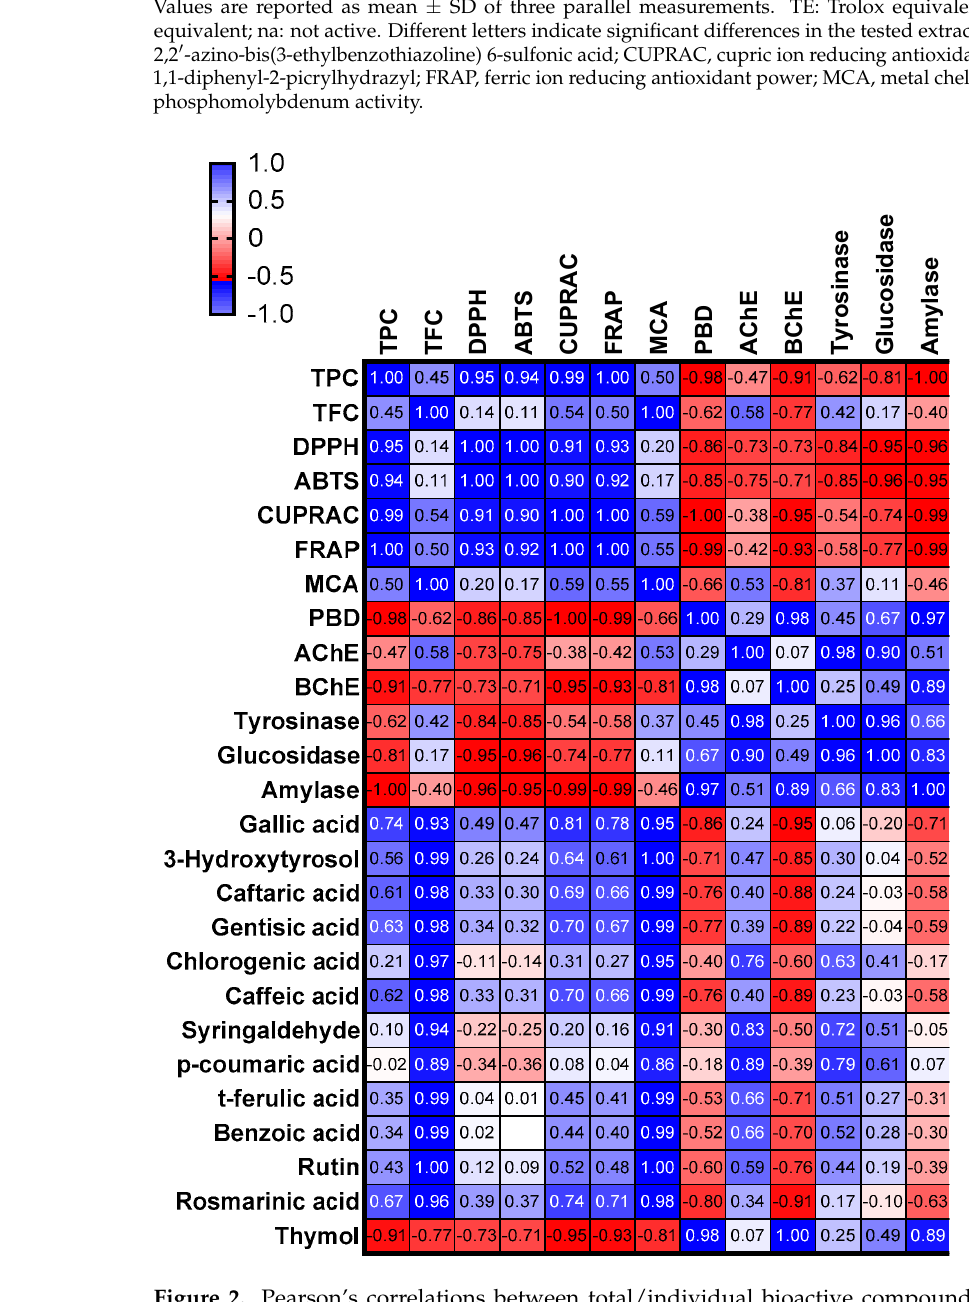
Figure 2. Pearson’s correlations between total/individual bioactive compounds and biological activ- ity assays ( p < 0.05). TPC: Total phenolic content; TFC: Total flavonoid content; ABTS, 2,2 ′ -azino-